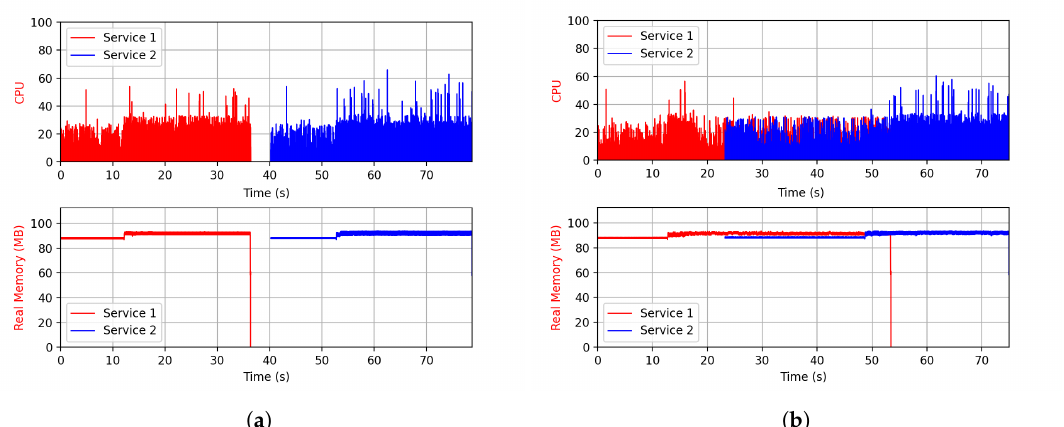
Figure 12. Resource comparison for two different services running on the general-purpose device.